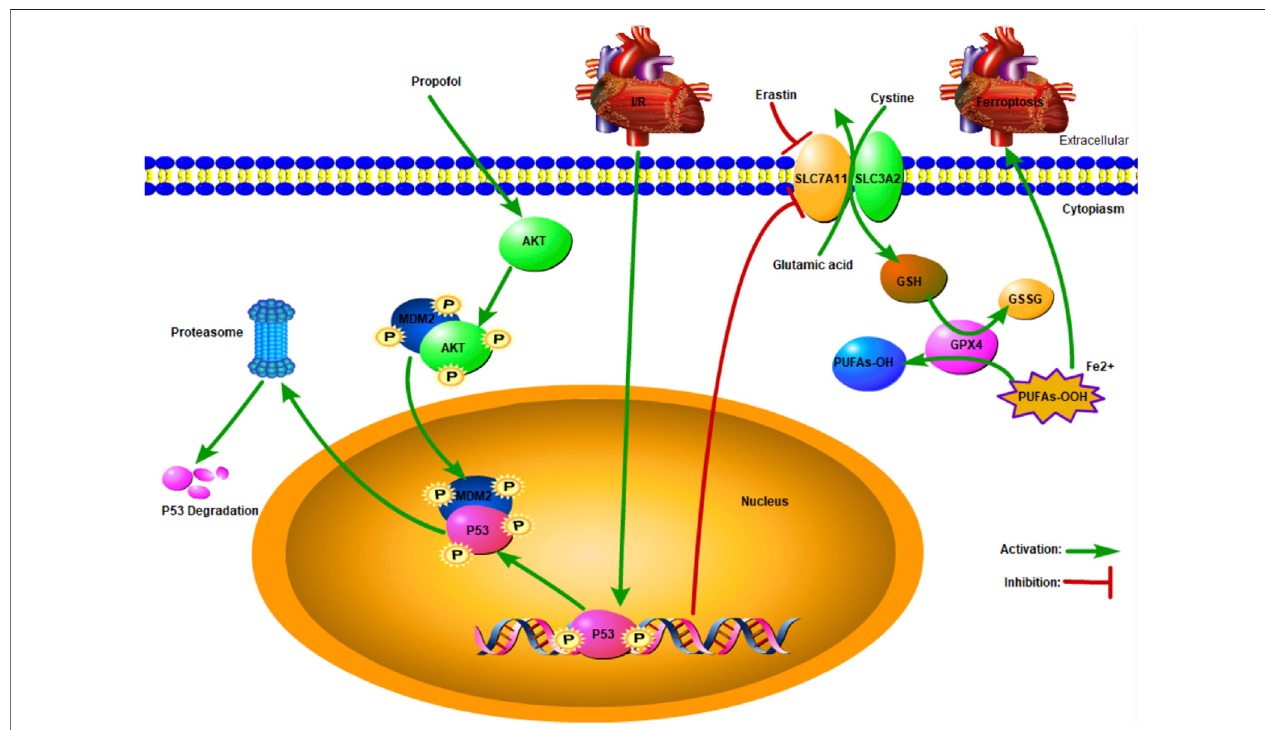
FIGURE 6 | Schematic: Propofol protects the myocardium from ischemia/reperfusion injury by in fl uencing an AKT/p53 signaling pathway-mediated ferroptosis mechanism.